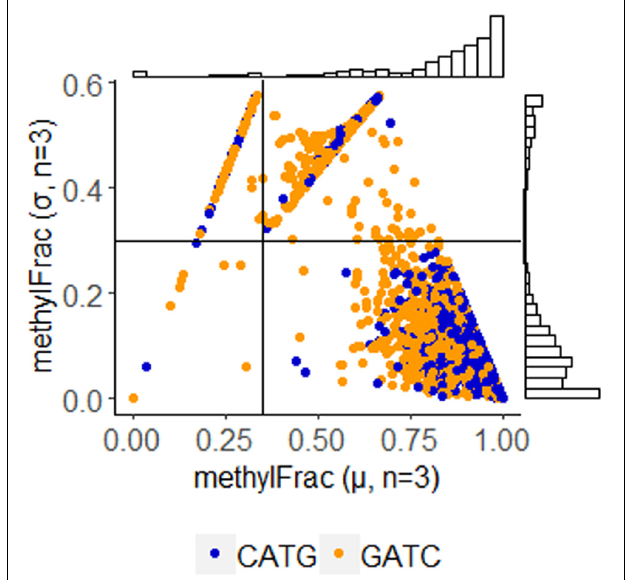
FIGURE 4 | Methylation stability of GATC and CATG tetramers among PBCV-1 replicates, analyzed at 30-fold read recruitment coverage. Each dot represents the average number of reads that were methylated (x-axis) and the deviation between three biological replicates (y-axis). An average value approaching one indicates stable methylation, meaning the site was methylated in 100% of the 30 reads. Position along the y-axis indicates stability of the methylation status, as a value of zero indicates the methylation status is consistent between the three replicates. Coordinates were used to easily bin methylation status and frequency as stably non-methylated (Q1 – 73 events, 21.9% CATG, 57% GATC); complete methylation in only one of the three replicates (Q2 – 457 events, 23.1% CATG, 76.9% GATC), complete methylation in only two of the three replicates (Q3 – 143 events, 24.3% CATG, 75.7% GATC), and stable complete methylation in all replicates (Q4 – 2,825 events, 58.1% CATG, 41.9% GATC). Histogram plots provide an estimate of how many events occur with the given